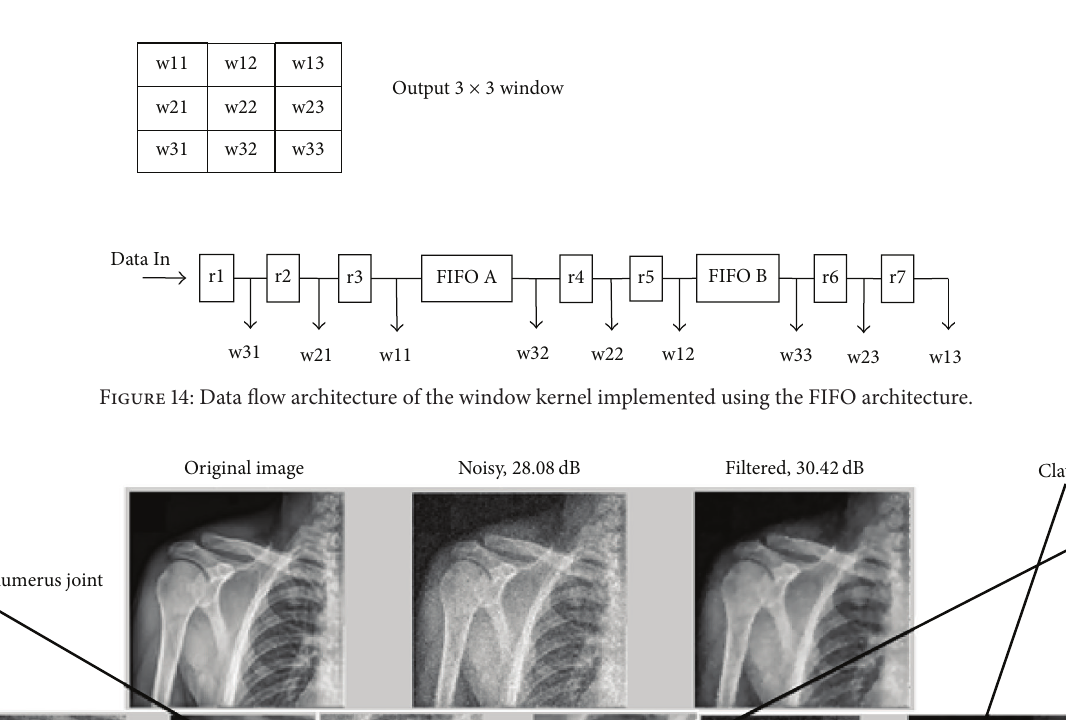
resource utilization (cf. Table